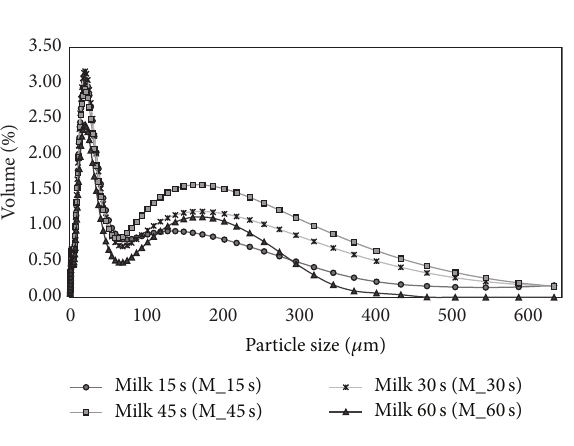
Figure 3: Particle size distribution of barley milk.